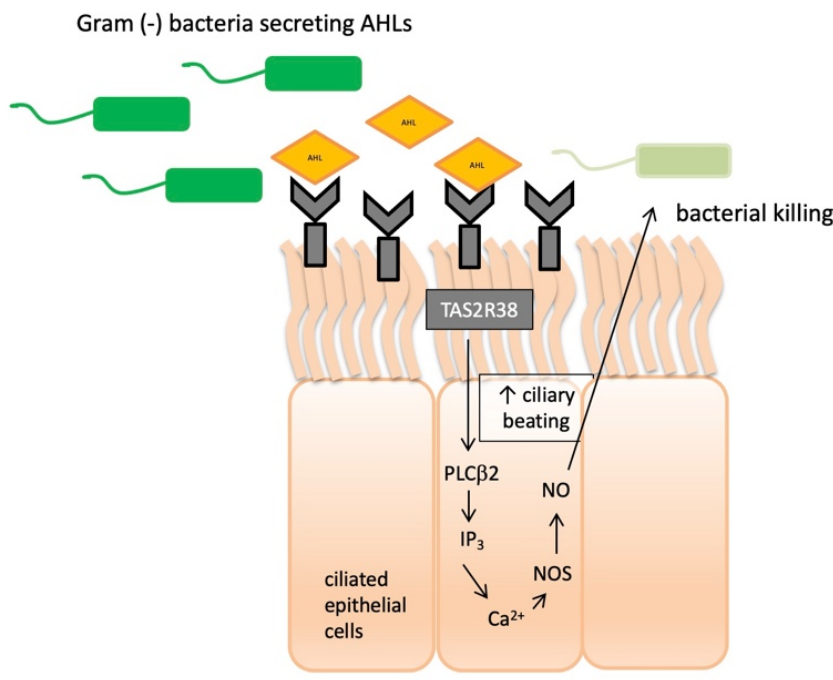
Figure 1. TAS2R38 bitter taste receptor regulation in human sinonasal epithelial innate immunity. AHLs = acyl-homoserine lactones; Ca 2+ = calcium ion; NO = nitric oxide; NOS = nitric oxide synthase; PLC β 2 = phospholipase; IP 3 = inositol trisphosphate.